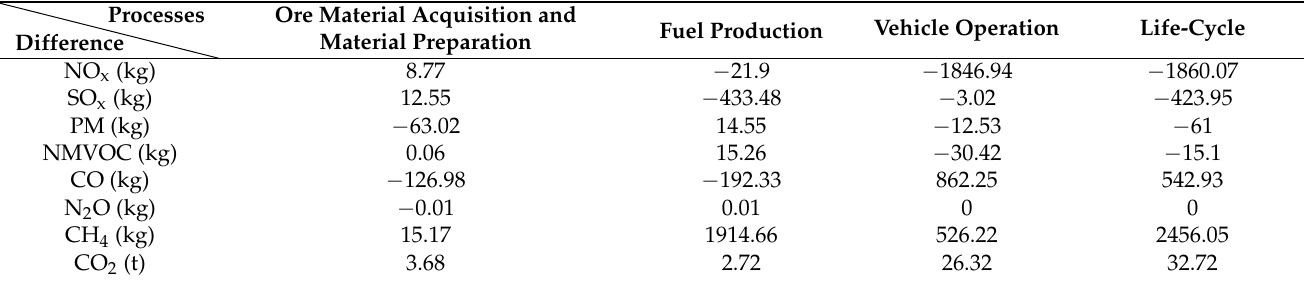
Figure 4. Air emissions of LNG compared to diesel tractor-trailer and contribution of different stages to the emission differences. Table 6. Air emissions of LNG tractor-trailer compared to diesel